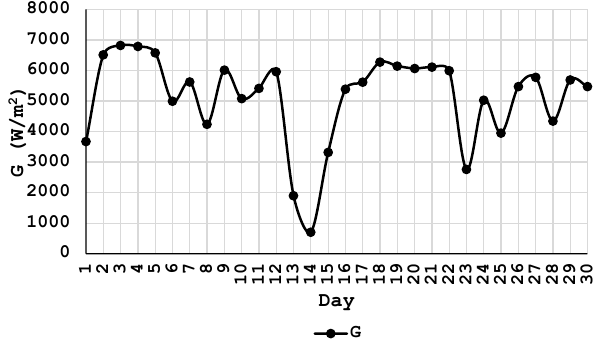
Figure 6. Total daily global radiation.